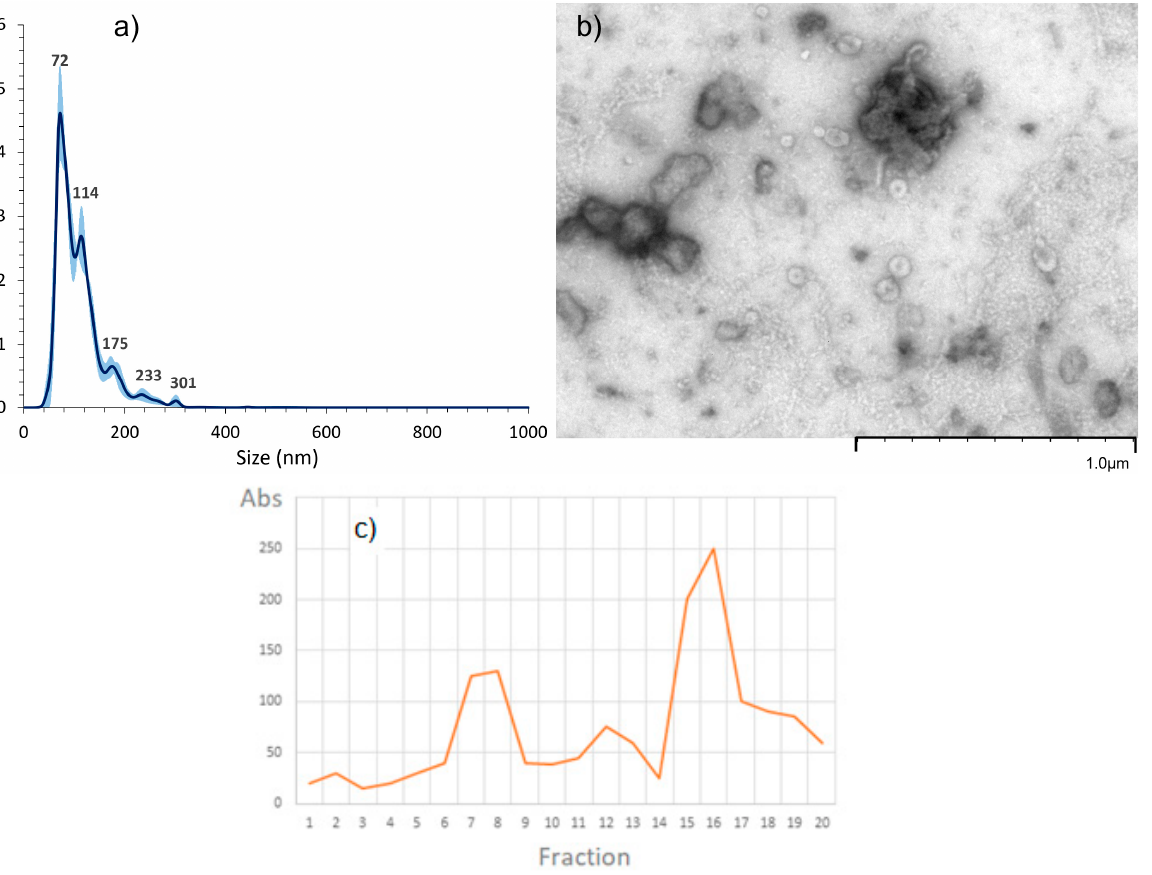
Figure 1. ( a ) Nanoparticle tracking analysis (NTA) and ( b ) transmission electron micrograph (TEM) of extracellular vesicles obtained after SEC on cMSCs (fraction 7–8) ( c ) qEV35 SEC separation with BCA protein quantification (absorbance at 570 nm).